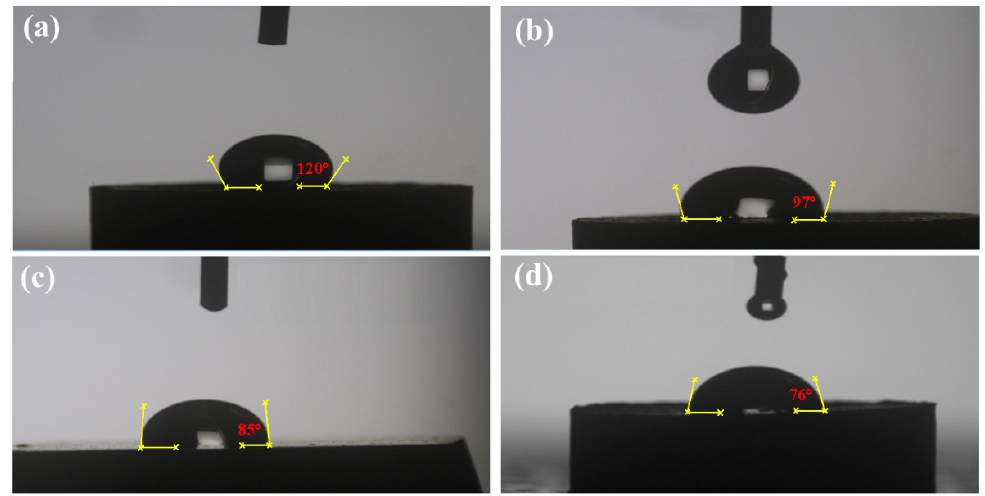
Figure 7. Contact angles of ( a ) MZ, ( b ) MC1, ( c ) MC2 and ( d ) MC3 composites after SPS process.